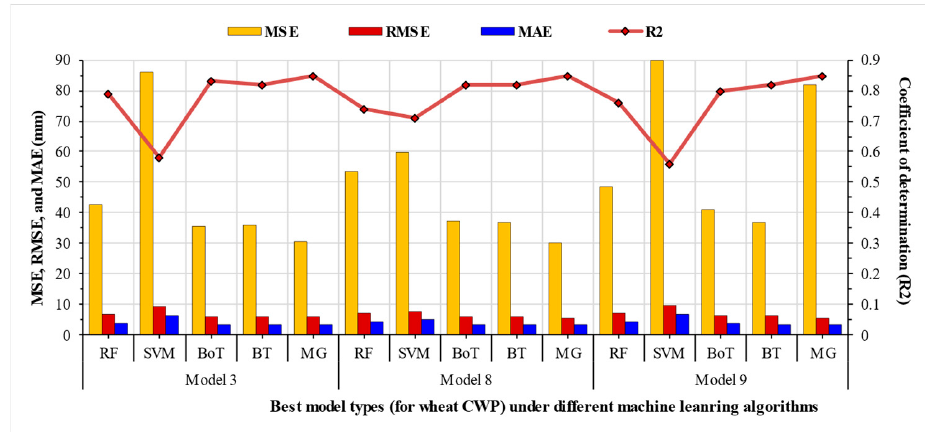
Highlighted models indicate best performance of machine learning algorithm considering R 2 , MSE, RMSE, and MAE.